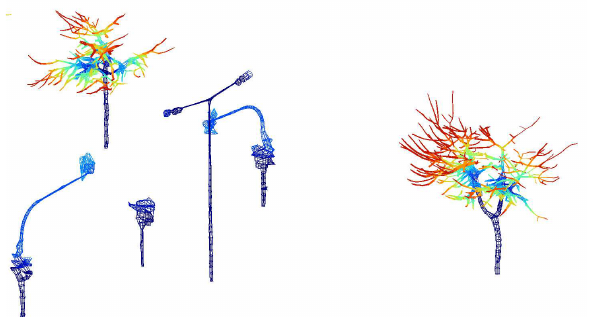
Figure 6. Skeleton reconstructions of pole supported objects. The branching levels are colour coded from low (blue) to high level (red). The estimated thickness of the point cloud around each skeleton segment is modelled as a connected pipe model.